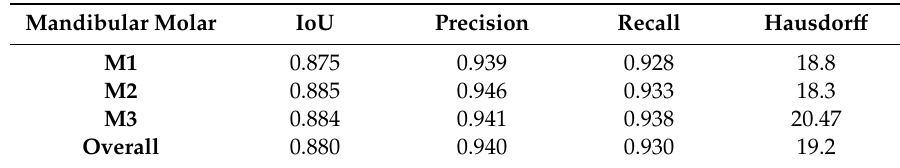
Table 1. Accuracy metrics of the new tool for automated molar segmentation and orientation calculation on panoramic radiographs. IoU = Intersection over Union; M1, M2, and M3 = first, second and third molar, respectively.